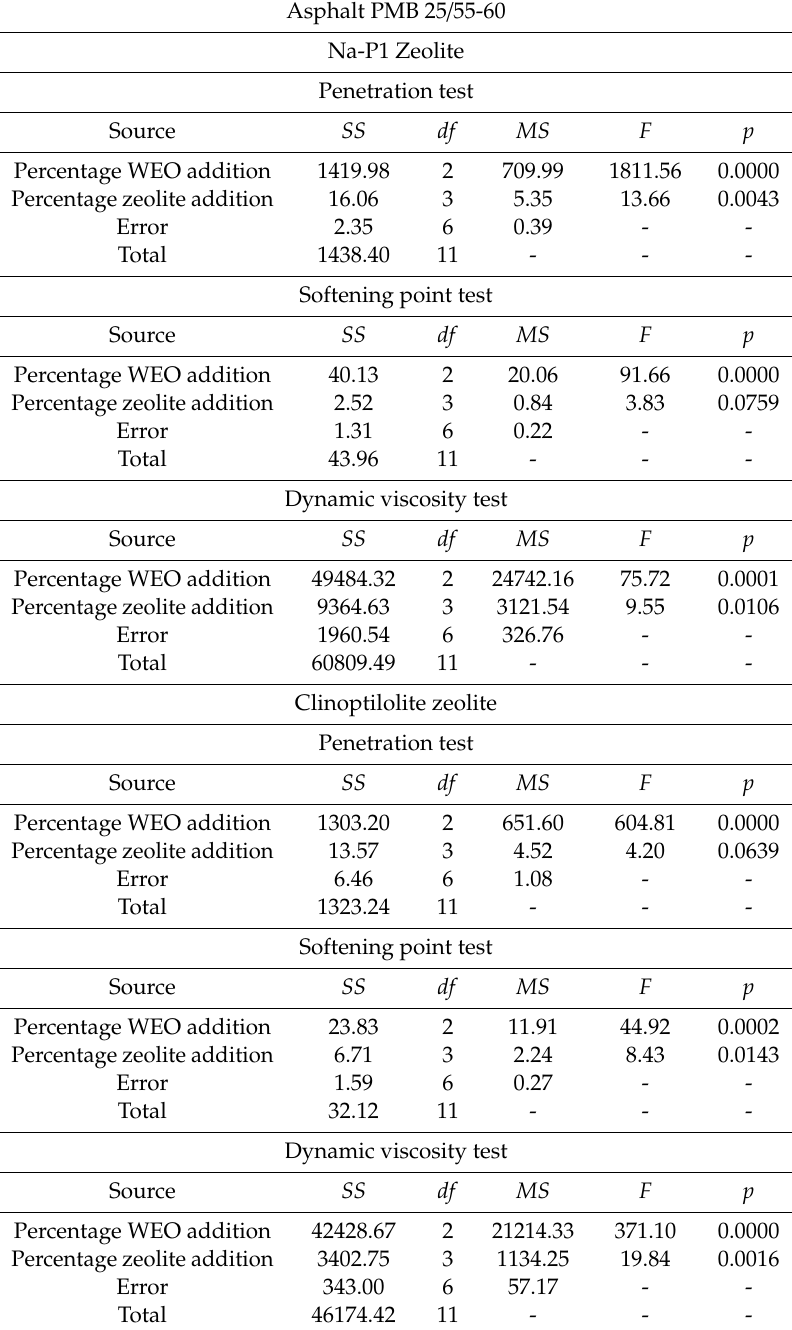
Table 4. ANOVA analysis on the parameters of the WEO-modified